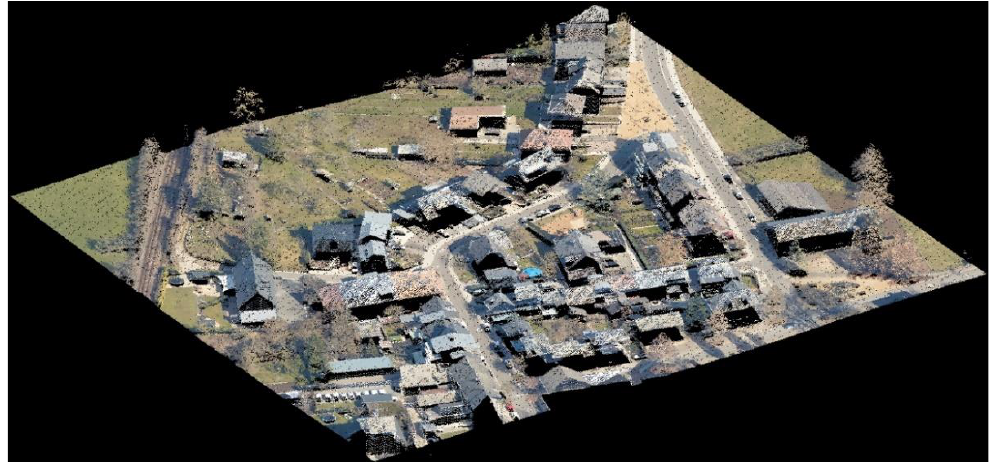
Figure 3. ACT test dataset in an urban area with trees, cars, and small-medium residential-commercial buildings.